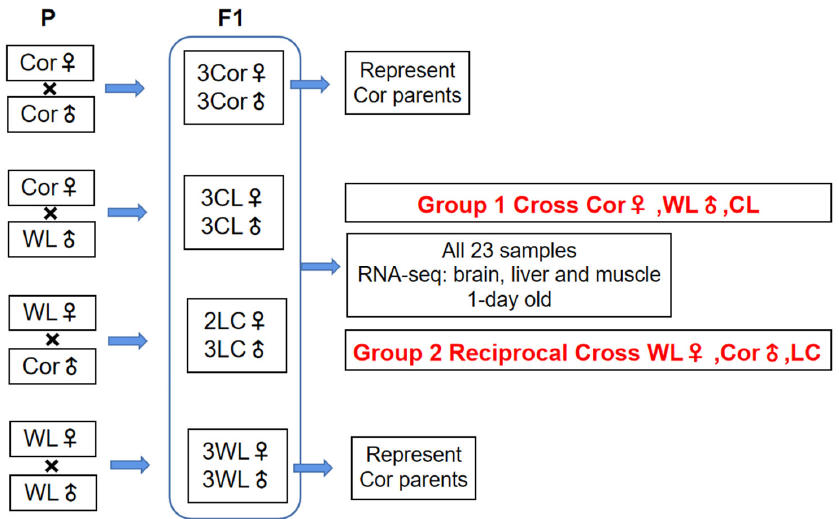
Figure 1. Samples and experiment design. Group 1 and Group 2 represent the cross and reciprocal cross, respectively. All analyses use female individuals for two groups in order to identify the expression of the W chromosome. Samples of three tissues (brain, liver, and muscle) were collected from all chicks one day after hatching for transcriptome sequencing.